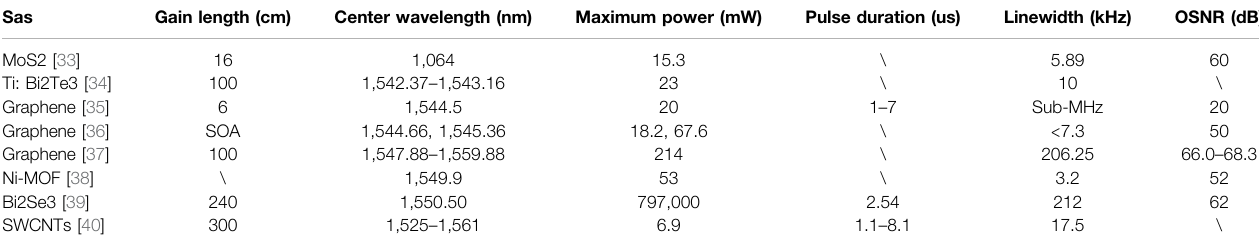
TABLE 1 | Research progress of narrow-linewidth single-frequency pulsed fi ber lasers based on low-dimensional materials. Sas Gain length